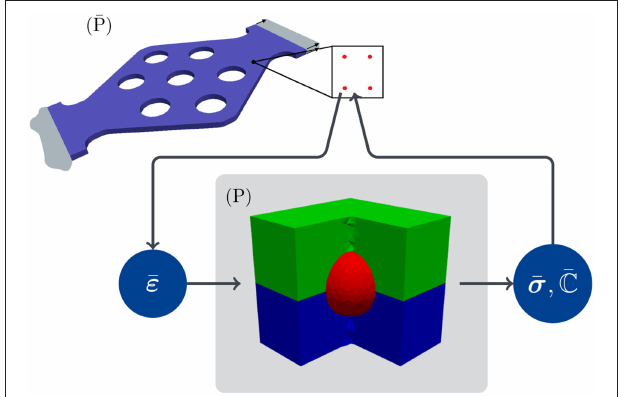
FIGURE 1 | Twoscale mechanical problem in the context of FE 2 for a material with a microstructure composed of three material phases: at every integration point of the macroscopic problem ( ¯ P) the microscopic problem (P) is solved in the FOM through a microscopic FE computation for prescribed ¯ ε , the resulting effective stress ¯ σ , and corresponding gradient ¯ C = ∂ ¯ σ /∂ ¯ ε are then computed and returned to the macroscopic integration